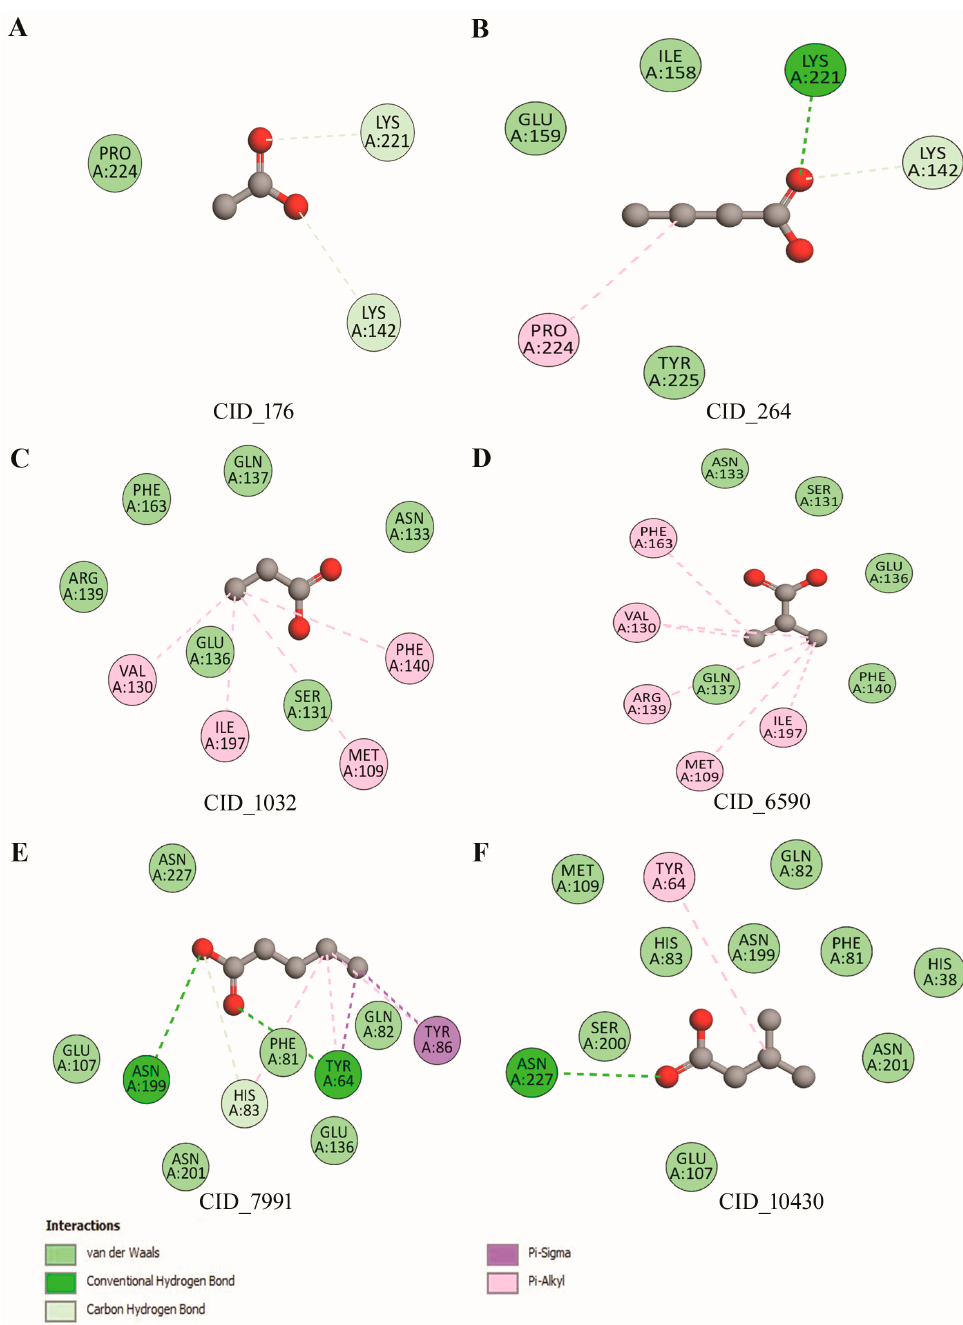
Figure 7. Interactions of the Lpp with the pheromones/volatiles. The 2D residue map of pheromone interactions with the Lpp is shown, and the residual interactions were observed below 4.0 Å. The acetic (CID_176) and butanoic acids (CID_264) have several H-bond interactions ( A , B ). Propanoic (CID_1032) and isobutyric (CID_6590) acids have hydrophobic and Pi-stacking interactions ( C , D ). Valeric (CID_7991) and isovaleric (CID_10430) acids exhibit H-bond, hydrophobic, Pi-Sigma and Pi-Alkyl interactions ( E , F